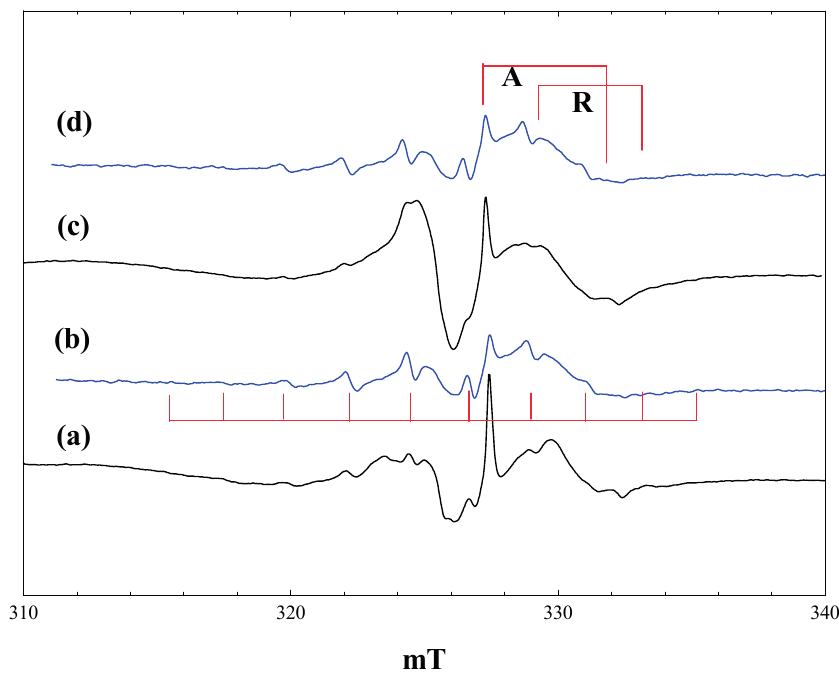
Figure 6. EPR spectra of P25 titania in an equimolar mixture of maleimide and pivalic acid in acetonitrile. (a), During irradiation with high intensity 400 nm light at 4 K; (b), during irradiation with high intensity 400-nm light at 80 K; (c), after irradiation with high intensity broad-band light at 4 K; (d), after irradiation with high intensity broad band light at 80